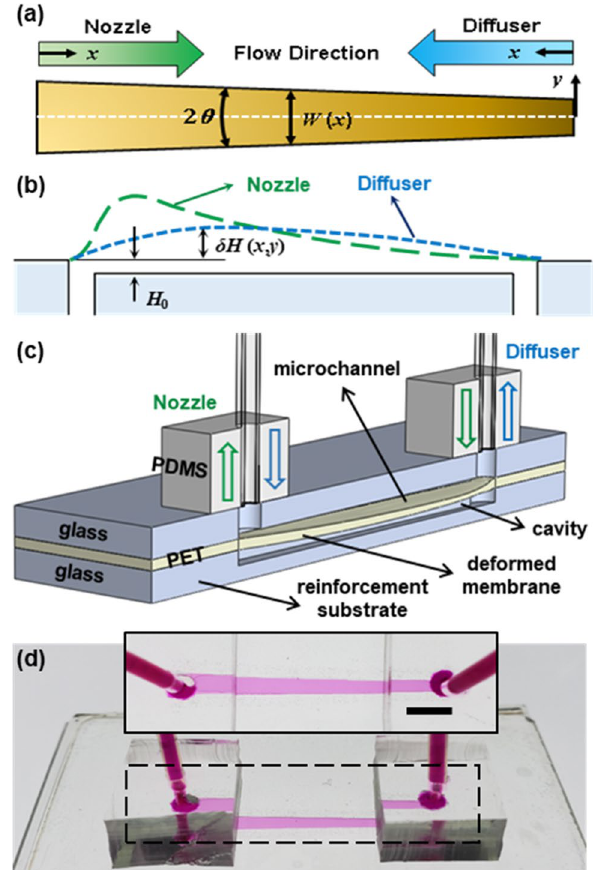
Figure 1. Schematic representations of a deformable nozzle/diffuser microchannel showing ( a ) a top-down view with the defined coordinate and channel dimensions, ( b ) a side view with the exemplary deformation profiles of a flexible ceiling under nozzle or diffuser configuration, ( c ) a 3D cross-sectional view with an assembled rectifier device; ( d ) a photograph of the fabricated deformable microchannel device ( W i W o 2 mm , and H 0 10.9 µ m ) filled with the dyed solution delineating the channel profile. Scale bar in the = = inset image is 2